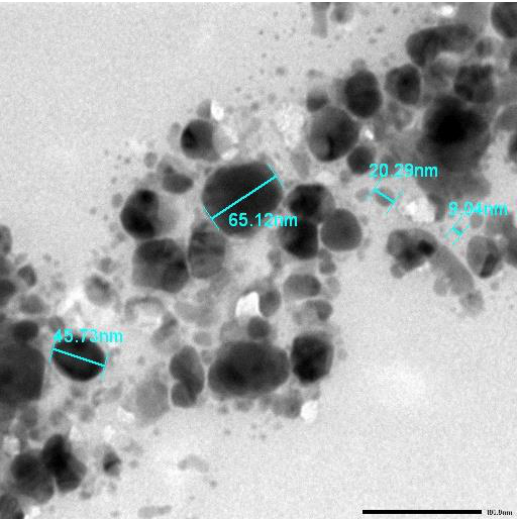
Figure 1. TEM image of nanoTiC p